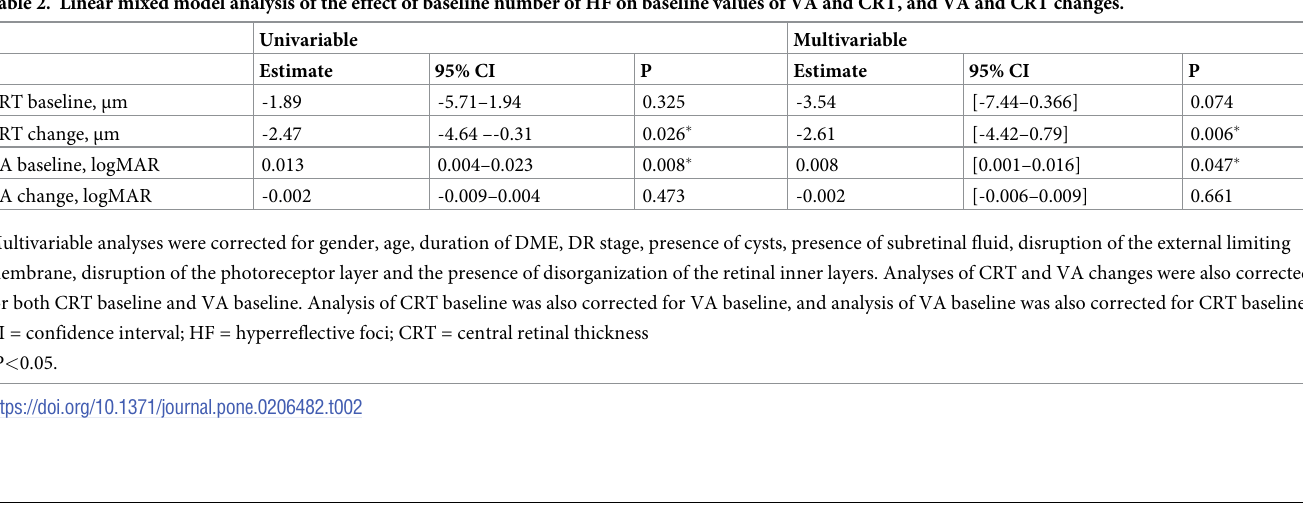
Table 2. Linear mixed model analysis of the effect of baseline number of HF on baseline values of VA and CRT, and VA and CRT changes.